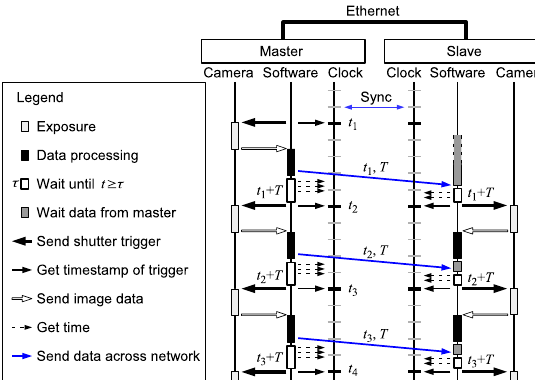
Figure 4. Proposed shutter synchronization scheme. The shutter of each camera is locally controlled based only on the local clock, thus avoiding network delays. The clocks are globally synchronized over Ethernet. The shutter trigger at the slave is determined based on the timestamps ( t 1 , t 2 ,...) and the frame interval ( T ) sent from the master. Although the data from master arrives after a network delay, the trigger timing calculated in the slave does not depend on the delay.